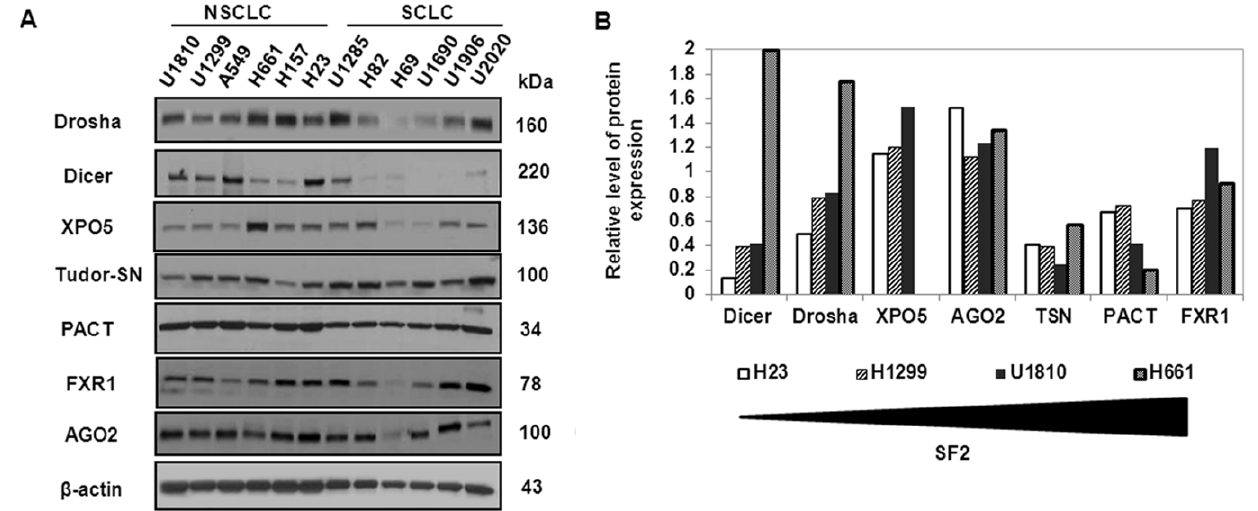
Figure 1. NSCLC and SCLC cells differ in sensitivity to radiation treatment and display differential expression of proteins involved in the regulation of miRNA biogenesis. (A) Western blot analysis of the level of protein expression of Drosha, Dicer, exportin 5 (XPO5), Tudor-SN (TSN), protein activator of the interferon-induced protein kinase (PACT), fragile X mental retardation syndrome-related protein 1 (FXR1) and Argonaute 2 (AGO2) in a panel of NSCLC (U1810, U1299, A549, H661, H157, H23) and SCLC (U1285, H82, H69, U1690, U1906, U2020) cell lines. (B) Densitometric analysis of relative levels of protein expression in H23, H1299, U1810 and H661 cell lines. Cell lines distributed according to radiosensitivity, measured as the fraction surviving at 2 Gy (SF2). Equal loading was verified using anti- b -actin antibodies. Results are representative of three independent experiments.